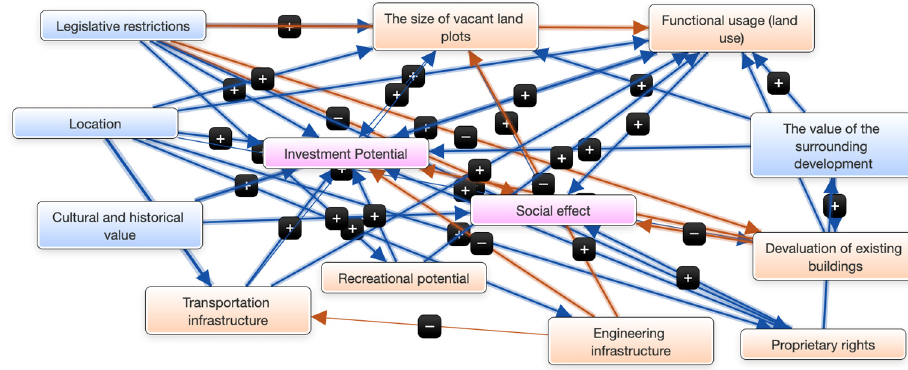
Figure 2. Cognitive map for the analysis of area development options.